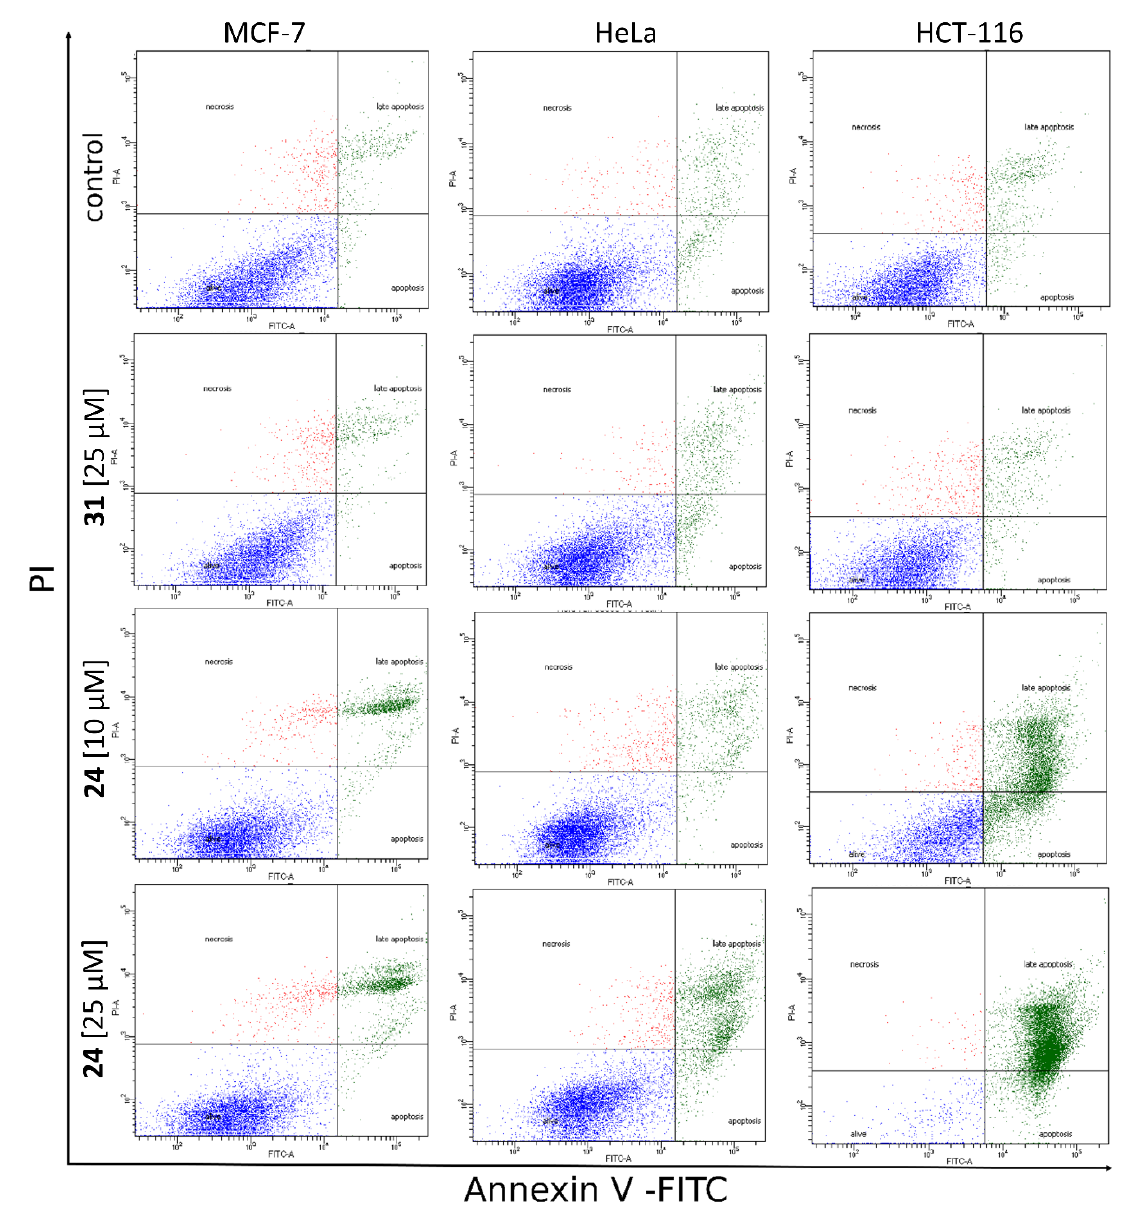
Figure 10. Features of dying process of MCF-7, HeLa, and HCT-116 cell lines. Dotblots show cells stained with Annexin V-FITC Apoptosis Kit. Cells were treated with 24 (10 μ M or 25 μ M) or 31 (25 μ M) for 72 h. Non-treated cells were used as a control. Quadrants Q1 (upper left), Q2 (upper right), Q3 (lower left), Q4 (lower right) show the following results: necrotic cells, late apoptotic cells, alive cells, apoptotic cells, respectively.